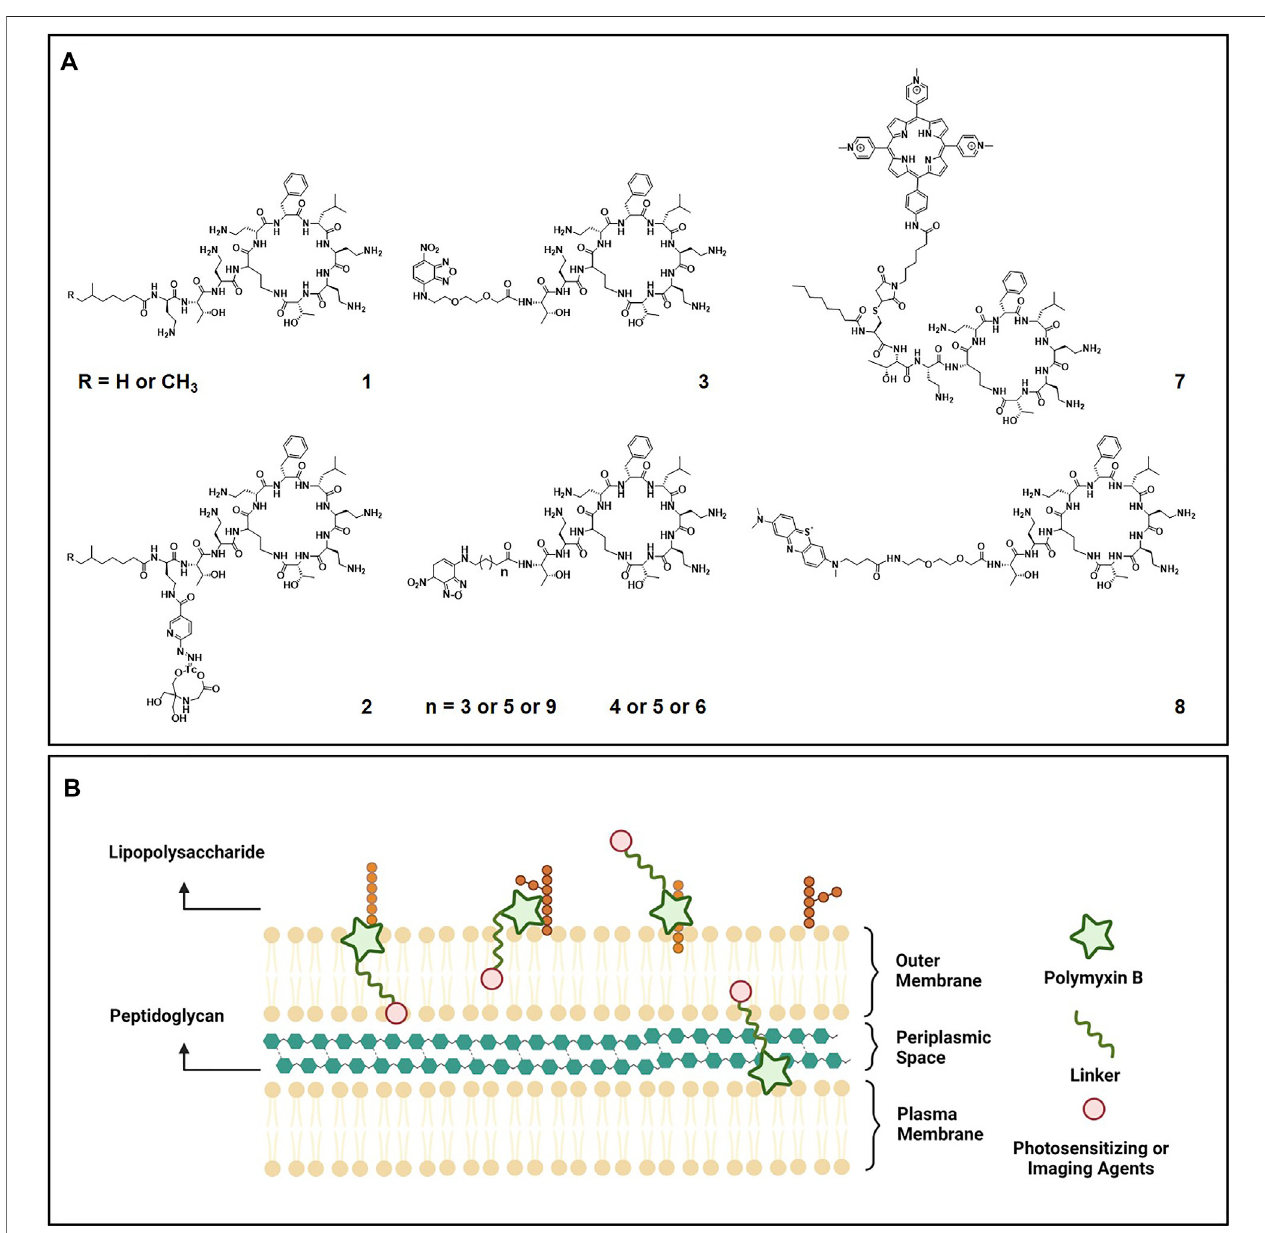
FIGURE 1 | (A) Chemical structures of polymyxin B (compound 1) and its engineered molecular imaging agent 99m Tc-HYNIC-PMB (compound 2), optical imaging agent NBD-PMB (compound 3-6), and photosensitizing agents (compound 7 and compound 8). (B) Illustration of the polymyxin B based imaging and photosensitizing agents targeting Gram-negative